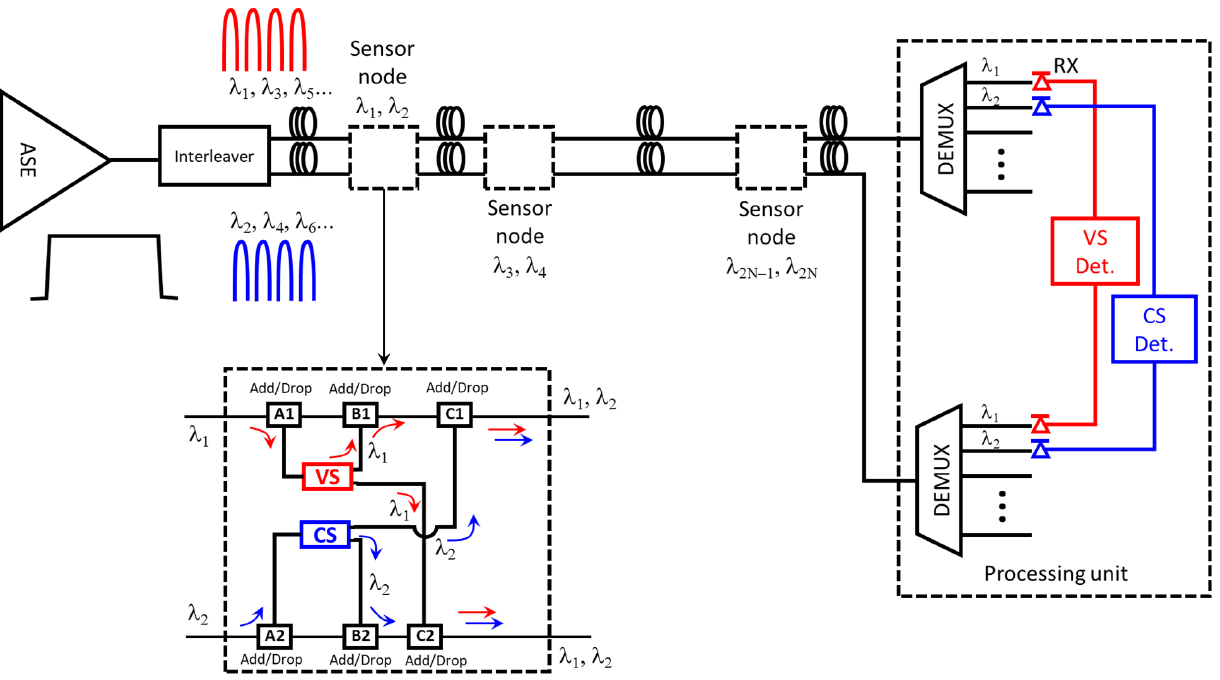
Figure 2. The general design of the current and voltage sensor network. An ASE light source, an interleaver, a current sensor using the Faraday effect, a voltage sensor using the Pockels effect, add/drop to separate the spectrum, and DEMUX for separate demodulation of the current and voltage signals are used.